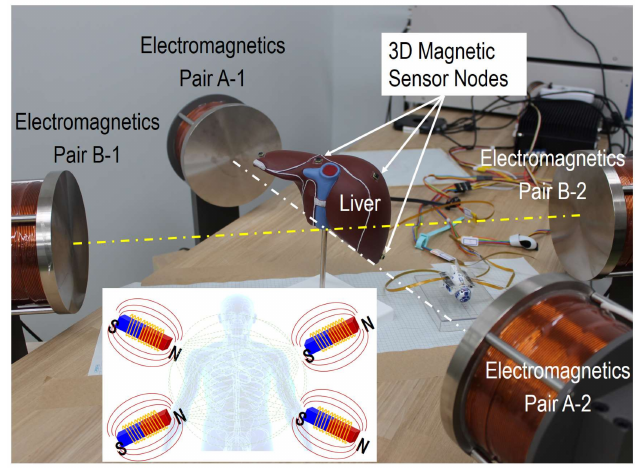
Figure 9. Photos and mechanism of the positioning system by using 3D magnetic sensors and artificial magnetic